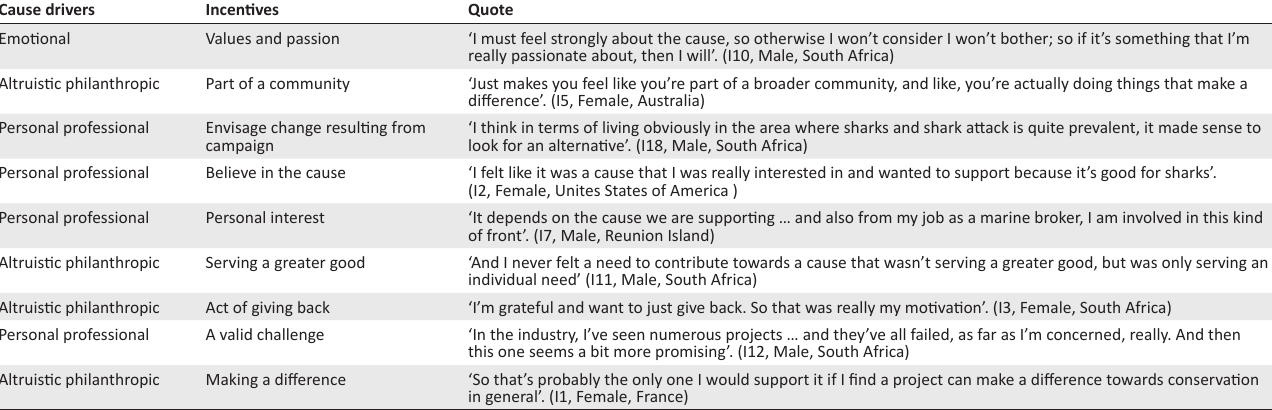
FIG URE 4: Relational framework of cause TABLE 2: Cause driver themes.